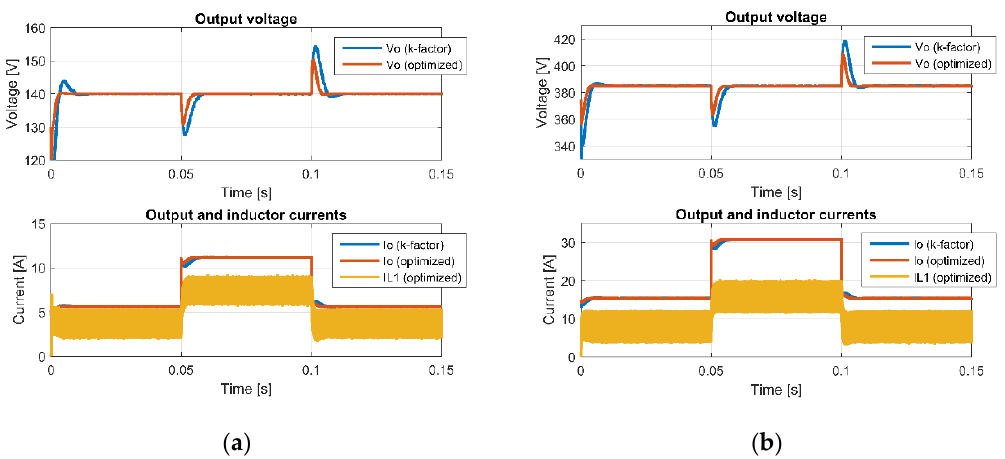
Figure A1. Comparative simulation results of ‘k-factor’ and optimal controller under positive/negative step load change 12.5 Ω/25 Ω when ( a ) V in = 70 V and V O = 140 V; ( b ) V in = 250 V and V O = 385 V.